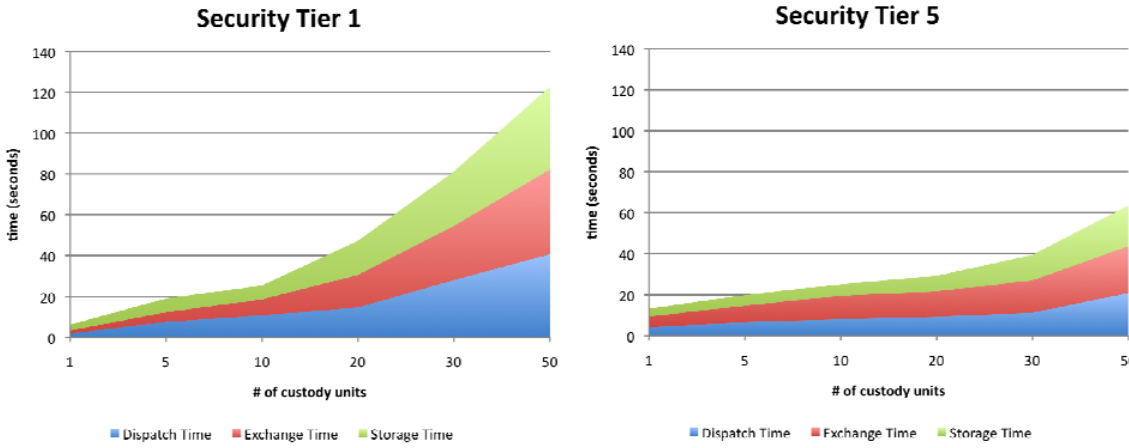
Figure 5. Time results for the Tier 1 and Tier 5 implementations.